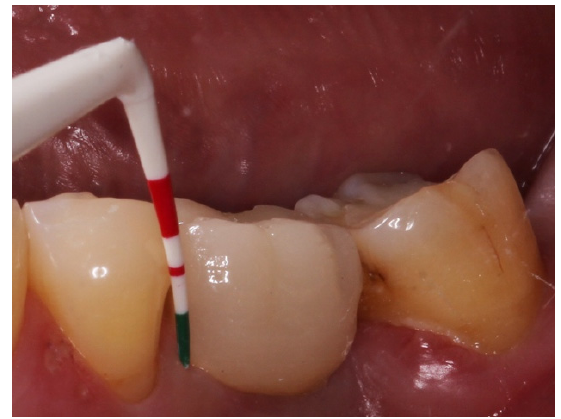
Figure 3. Probing depth using a plastic periodontal probe.